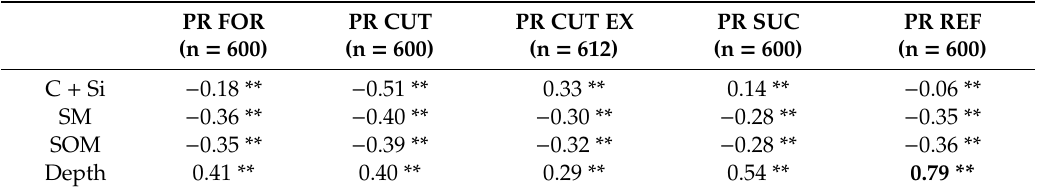
Table 19. Spearman-correlation for penetration resistance (PR), clay + silt content (C + Si), soil moisture (SM), soil organic matter (SOM). Strong ( < − 0.700, > 0.700) and very strong ( < − 0.900, > 0.900) correlations are indicated bold.